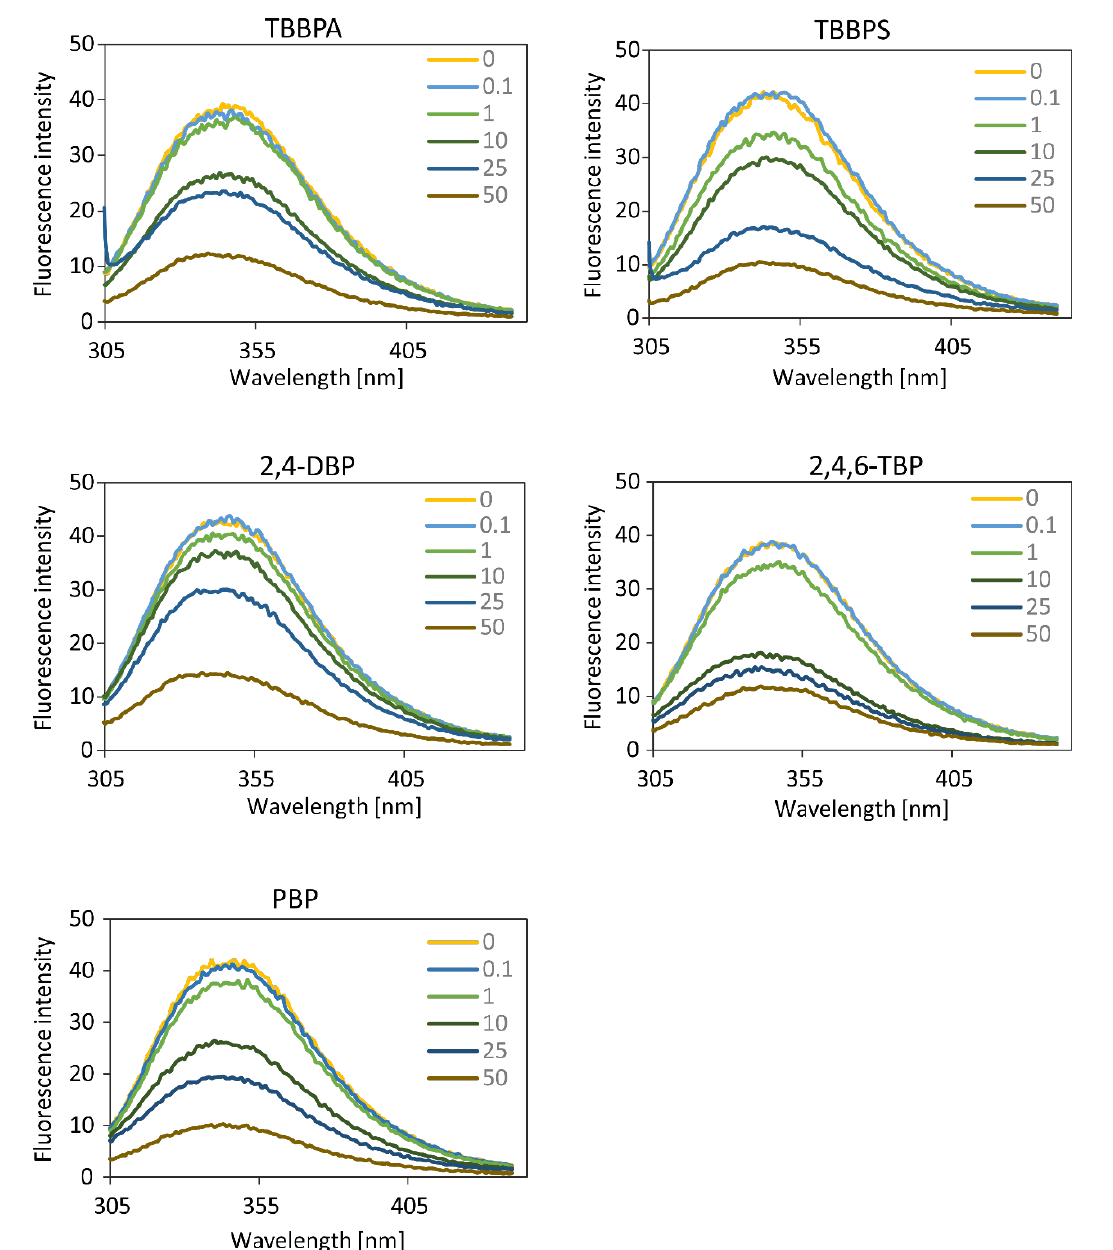
Figure 1. Human serum albumin ( HSA, 5 µ M) tryptophan residue quenching by tetrabromobisphenol A (TBBPA), tetrabromobisphenol S (TBBPS), 2,4-dibromophenol (2,4-DBP), 2,4,6-tribromophenol (2,4,6-TBP) and pentabromophenol (PBP) at the concentrations ranging from 0.1 to 50 μg/mL.; λexc = 290 nm.